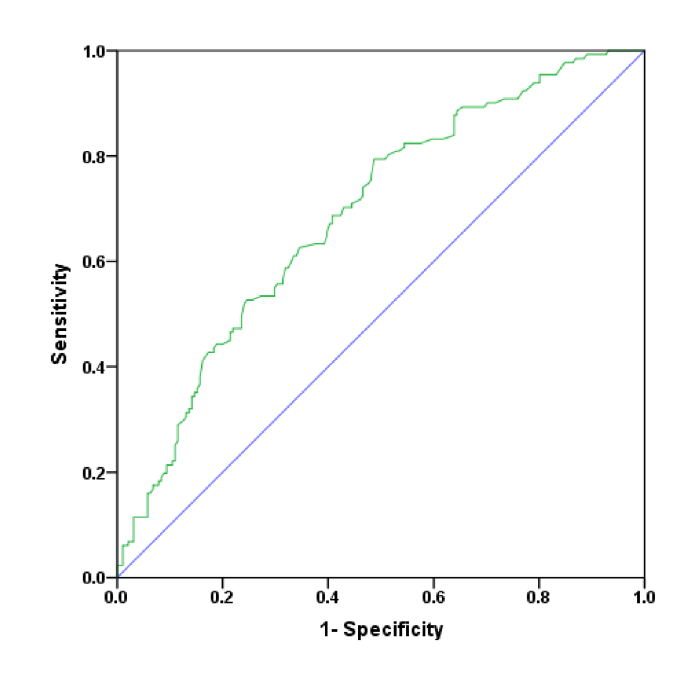
Fig. 2 - Receiver operation characteristic curve for predicting nosocomial infection with duration of extracorporeal membrane oxygenation support (area under the curve 0.689, 95% confidence interval 0.631-0.747,